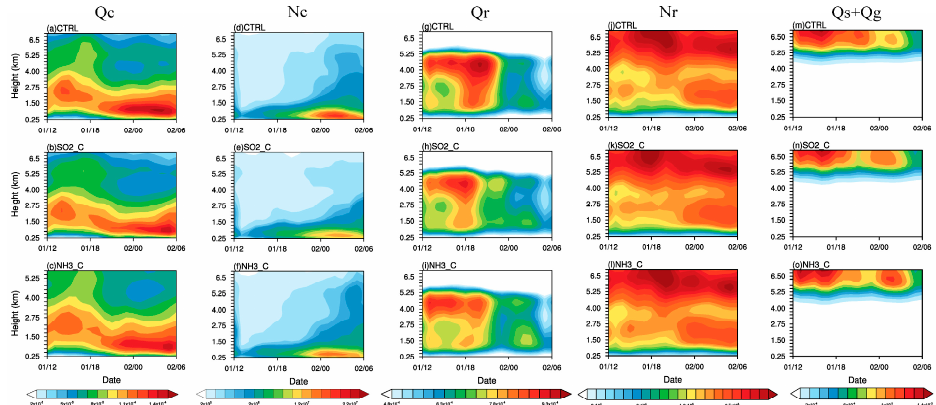
Figure 10. Time-height evolutions of area-averaged ( a – c ) mixing ratio ( kg kg (cid:2879)(cid:2869) ) and ( d – f ) number concentration (kg (cid:2879)(cid:2869) ) of cloud droplets, ( g – i ) mixing ratio ( kg kg (cid:2879)(cid:2869) ) and ( j – l ) number concentration (kg (cid:2879)(cid:2869) ) of raindrops, ( m – o ) mixing ratio ( kg kg (cid:2879)(cid:2869) ) of snow and graupel within the vortex. The top, middle, and bottom rows represent the CTRL, SO2_C and NH3_C runs, respectively.